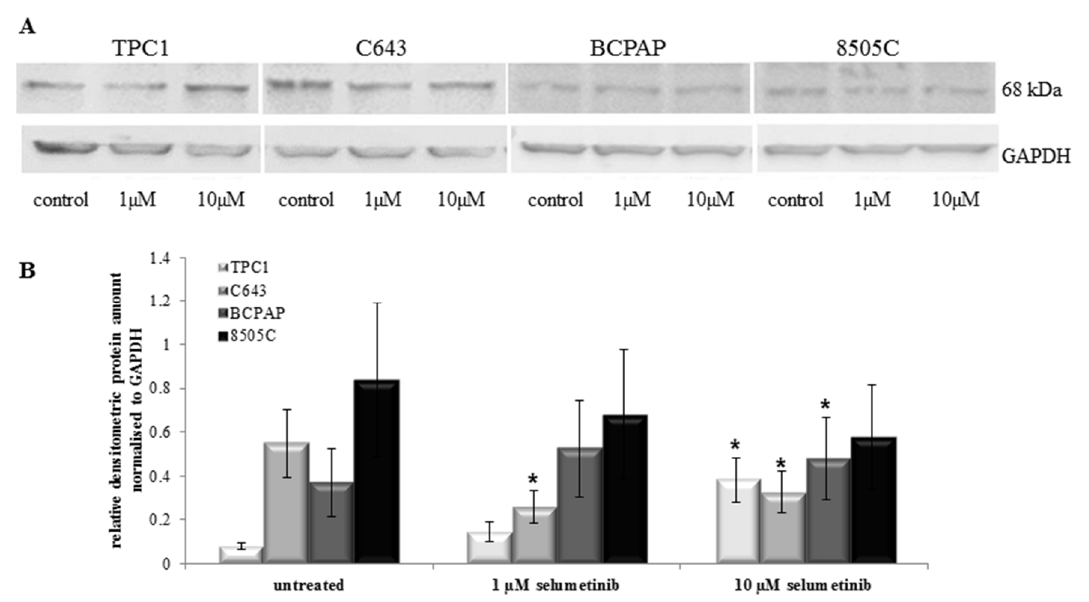
Figure 7. Selumetinib effect on NIS protein level. ( A ) Western blotting analysis (SDS-Page 4–12%, 50 µg protein/lane) of NIS protein in TPC1, C643, BCPAP and 8505C cells treated with selumetinib at indicated concentrations and probed with an anti-NIS antibody (clone FP5A) . Human GAPDH was used as an equal loading control; ( B ) densitometry of Western blot bands of NIS normalised vs. GAPDH. Means ± SEM are shown. * p < 0.05 regarded as significant.